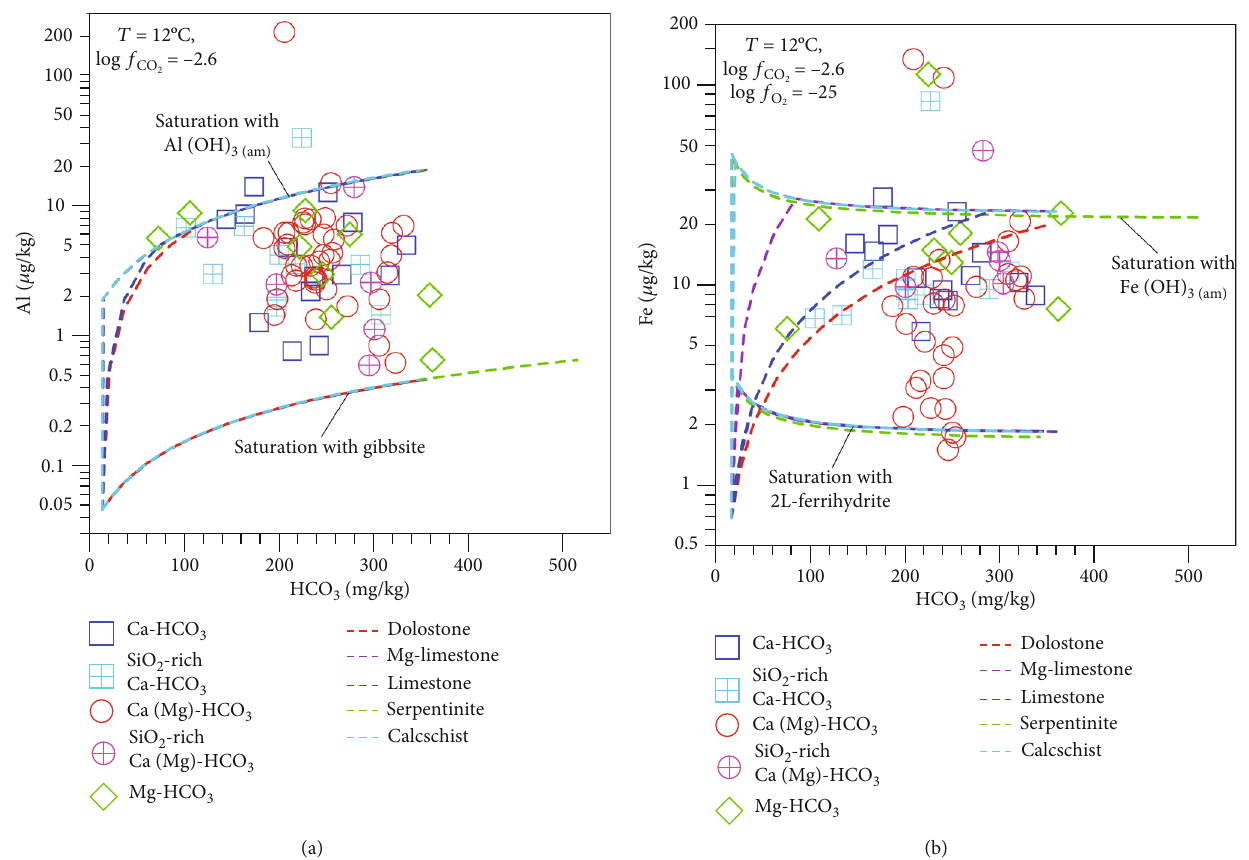
Figure 8: Correlation diagrams of alkalinity (expressed in mg HCO di ff erent rocks (see legend) according to the simulations elaborated in this